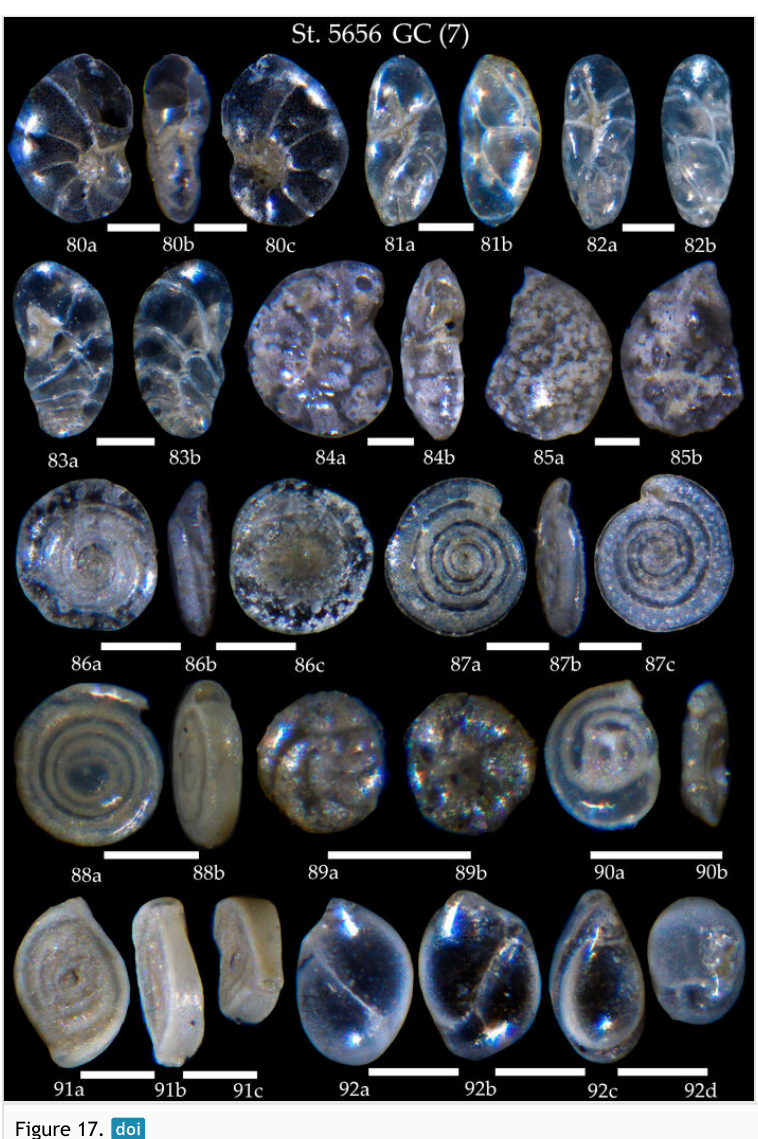
Figure 17. Station 5656 GC (continued). 80 Nonion sp., cf. N. faba , a spiral view, b apertural view, c umbilical view; 81,82 Robertinoides bradyi , a apertural view, b lateral view; 83 Geminospira bradyi , a apertural view, b lateral view; 84 Hyalinea balthica , a side view, b apertural view; 85 Sp.; 86 Mychostomina revertens , a spiral view, b apertural view, c umbilical view; 87 Spirillina viviparina , a spiral view, b apertural view, c umbilical view; 88 Cornuspira involvens , a side view, b apertural view; 89 Facetocochlea pulchra , a spiral view, b umbilical view; 90 Spiroloculina sp., a side view, b apertural view; 91 Spiroloculina depressa , a, b side view, c apertural view; 92 Globobulimina pacifica , a-c side view, d apertural view. Scale 100